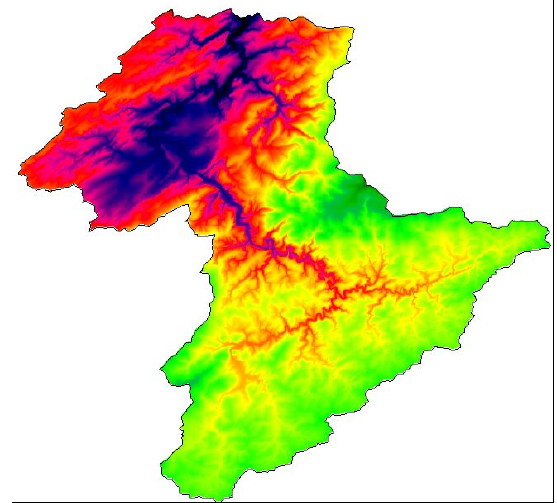
Figure 1. Topography of the Ourthe catchment, 117–650